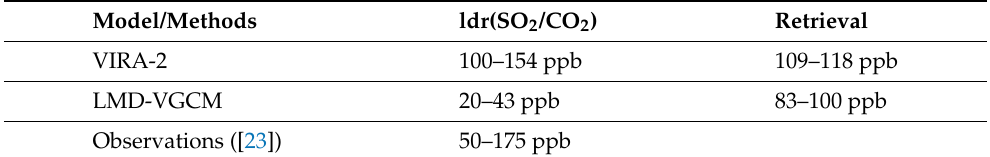
Figure 9. Best fits obtained for TEXES data. The VIRA-2 model provides the simulation with the best match to data. The fitted parameters were the SO 2 vertical abundance profile and the telluric water absorption. The telluric water absorption is at 1350.1–1350.3 cm − 1 . The line positions identified corresponds to those of HITRAN [56] (see Table 1) and matches the identification made by Encrenaz et al. [23]. The uncertainty of the datapoints of the observations is approximately 5%. The error of the simulations is approximately 0.1%. Blue—data; green—LMD-VGCM model; orange— VIRA-2 model. Table 2. Estimated abundance of SO 2 for a combination of different models and methods. The lower value of the VIRA-2 model using the line depth ratio method corresponds to a situation where the abundance of SO 2 is derived without including telluric absorption in the simulation. The range of abundance of SO 2 derived from observations comes from spatial and temporal